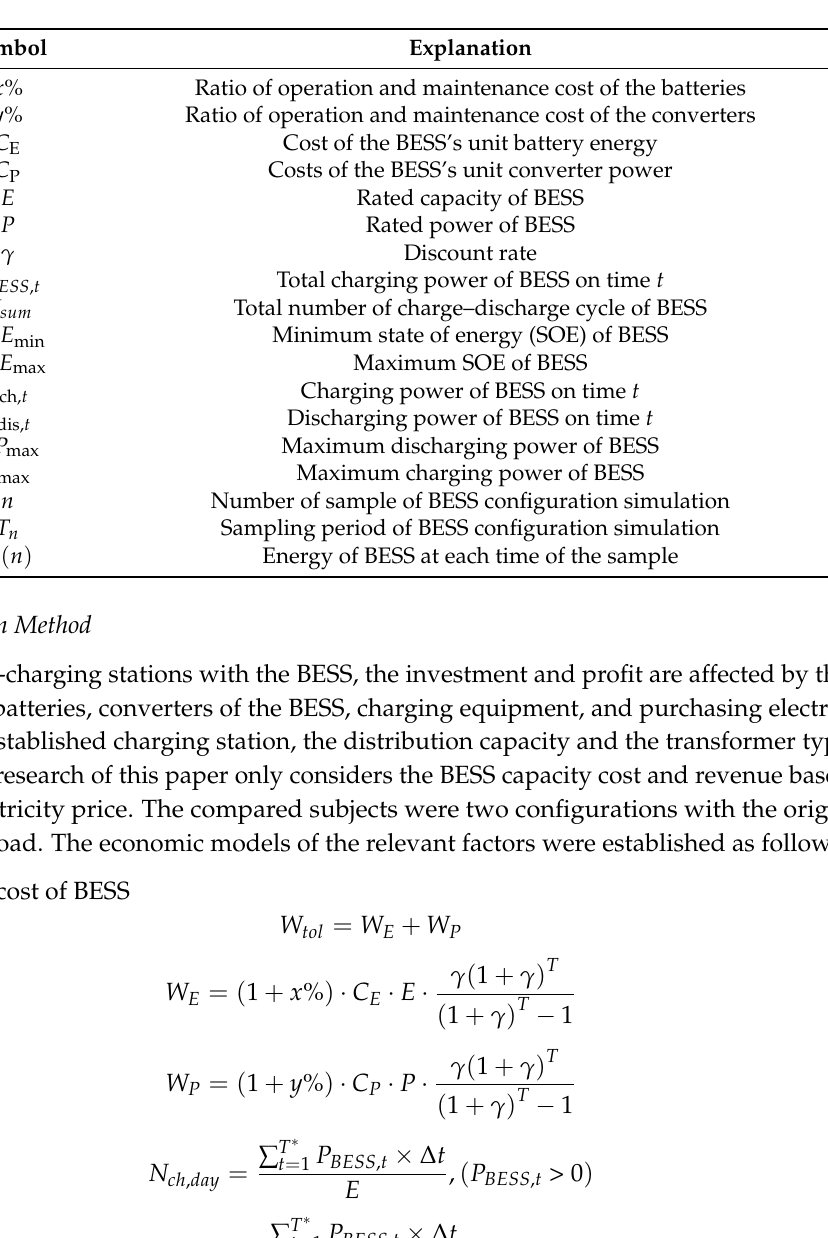
Table 5. List of some symbols used in the battery energy storage system (BESS)